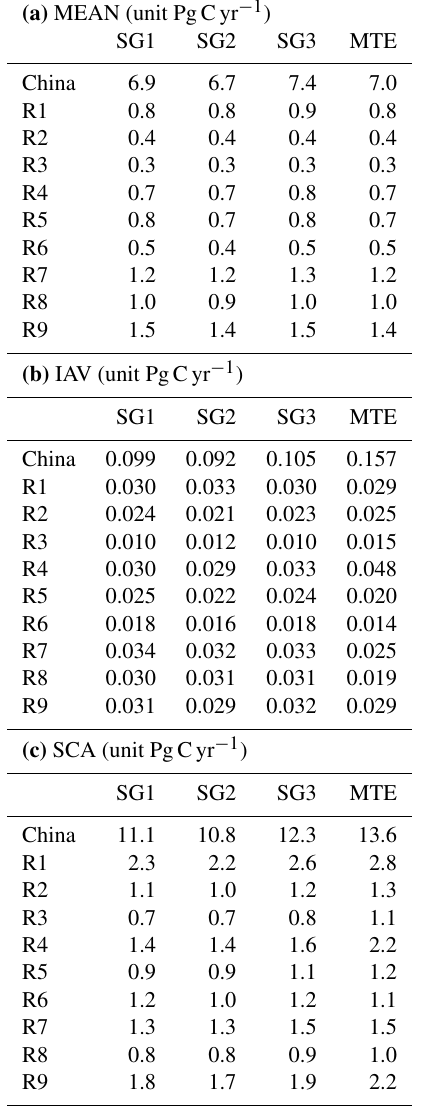
Table 1. China and regional GPP from the MTE and the ensem- ble mean of the 12 MsTMIP models for three configurations (SG1, SG2 and SG3): (a) mean values (MEAN), (b) interannual variabil- ity (IAV), (c) seasonal-cycle amplitude